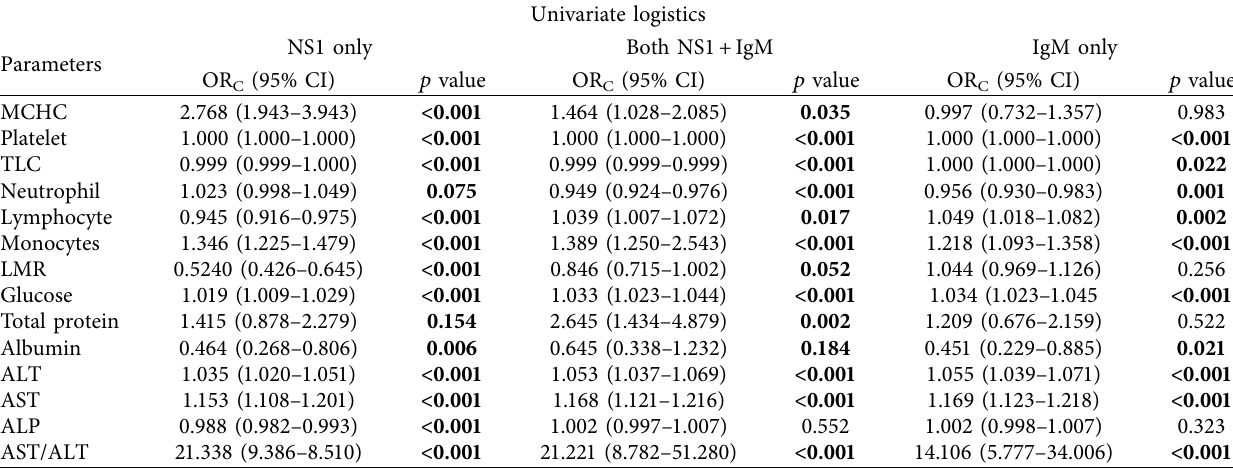
Table 5: Univariate logistic regression analysis for laboratory parameters in the NS1-only, both NS1 +IgM, and IgM-only positive dengue patients.